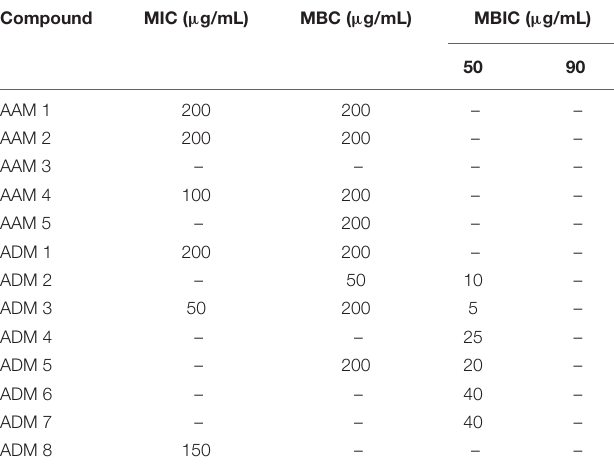
TABLE 2 | Antimicrobial and antibiofilm values of acyclic amines and diamines.